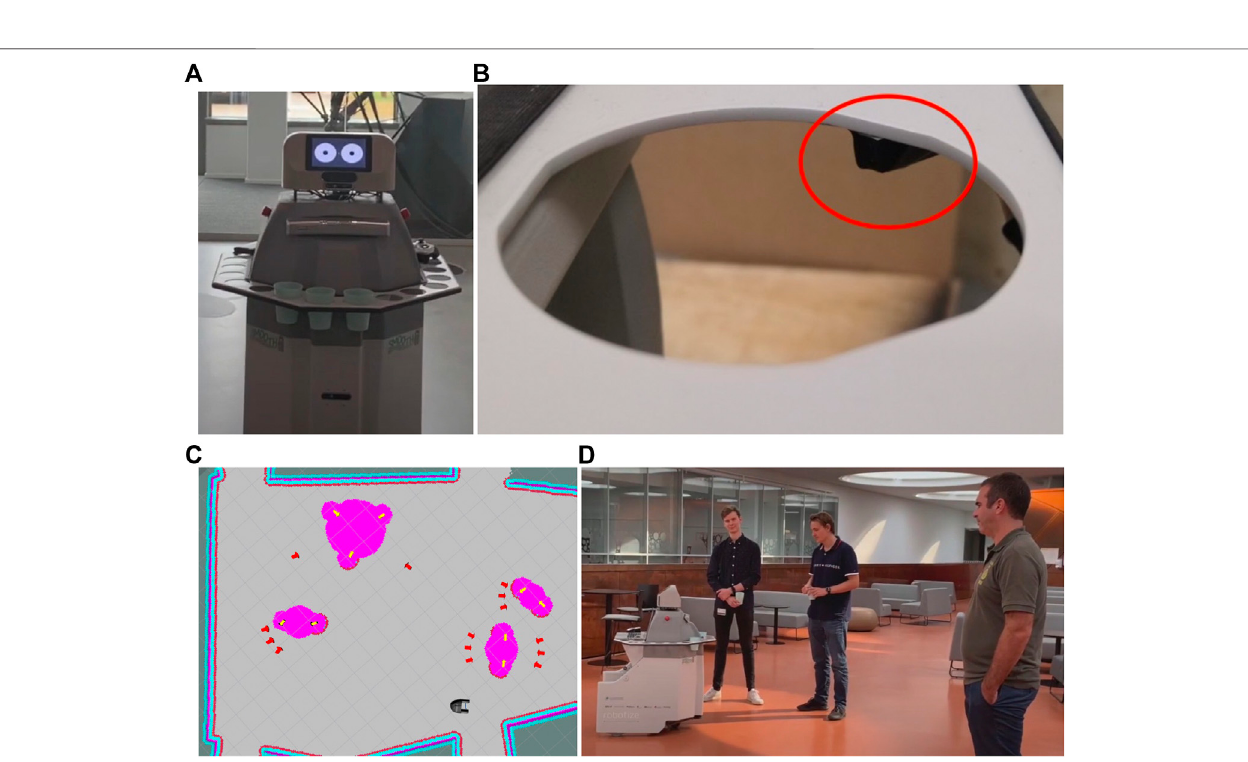
Frontiers in Robotics and AI |